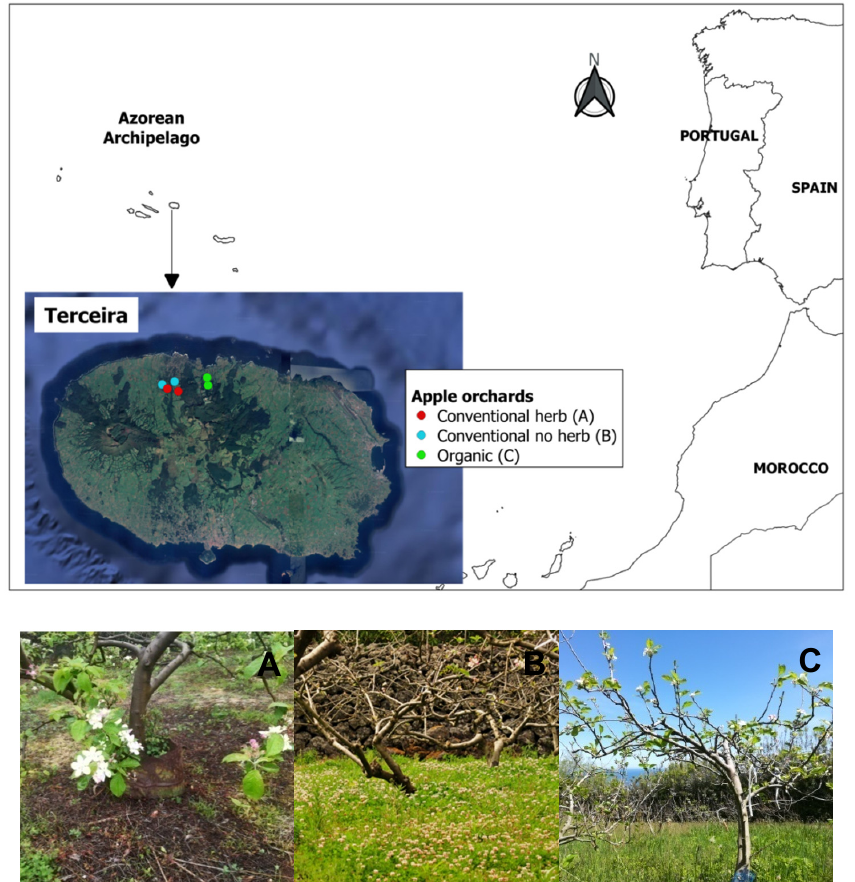
Figure 1. Location of the study sites in Terceira Island (Azorean archipelago) and example images of the three types of apple orchards studied, under different management systems: ( A ) Conventional with herbicide application; ( B ) Conventional without herbicide application; ( C ) Organic apple orchards.